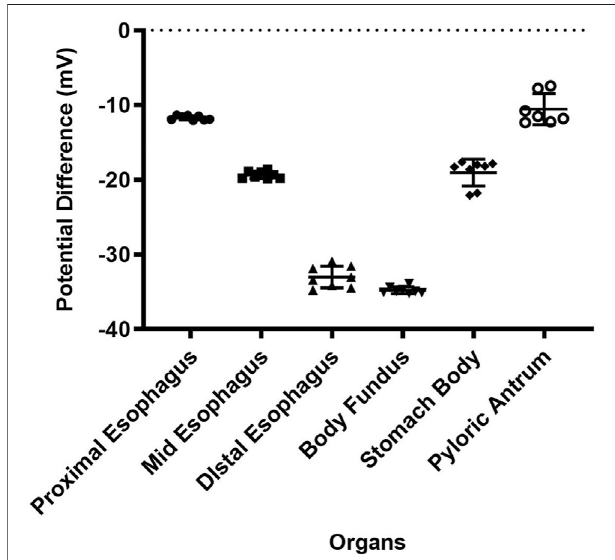
FIGURE 4 | PD values of proximal esophagus, mid esophagus, distal esophagus, body fundus, stomach (body) and the pyloric antrum. Error bars indicate